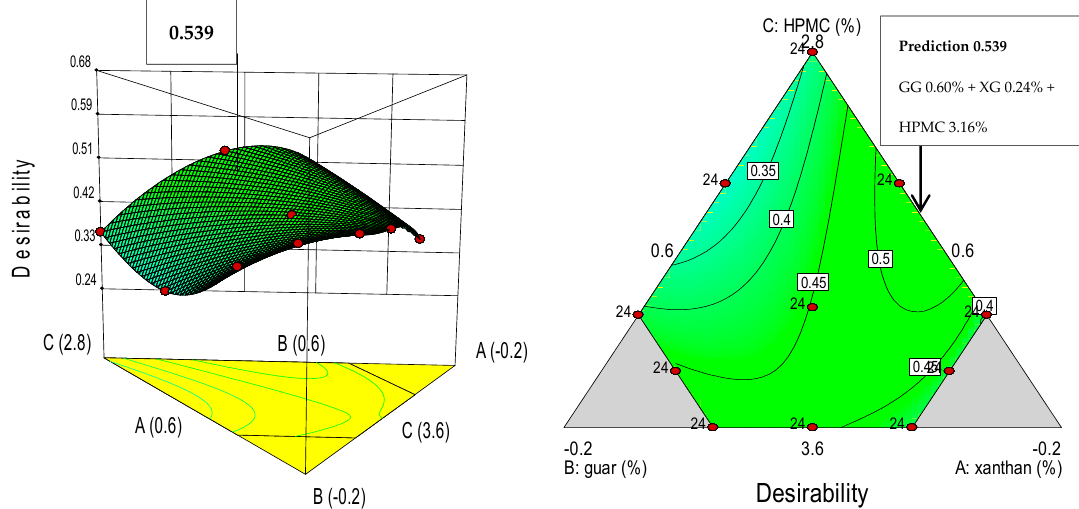
Figure 6. Three-dimensional desirability ( left ) and two-dimensional desirability contour ( right ) plots of the predicted optimal solution of xanthan, guar, and HPMC gums determined by desirability function analysis.